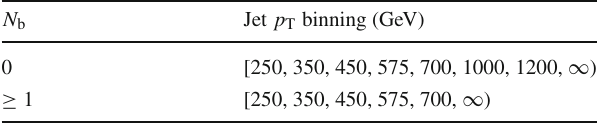
Table 5 Summary of signal regions for the monojet selection